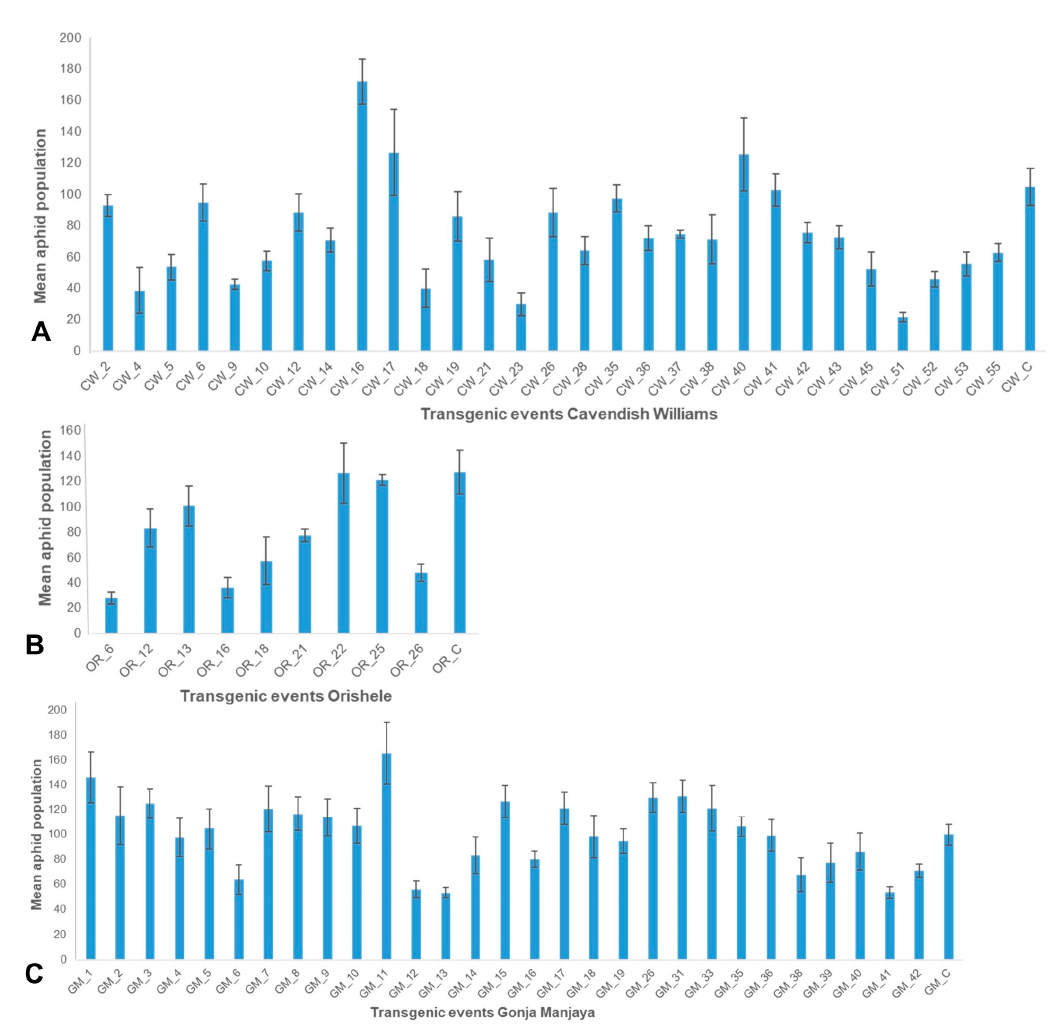
Figure 7. Relative change in aphid populations on dsRNA- AChE transgenic plants compared to nontransgenic control plants upon challenge with aphids. ( A ) Cavendish Williams, ( B ) Orishele, ( C ) Gonja Manjaya. The different number of transgenic events indicates the independent events generated for the three cultivars tested. Data are presented as LSmean values and standard error